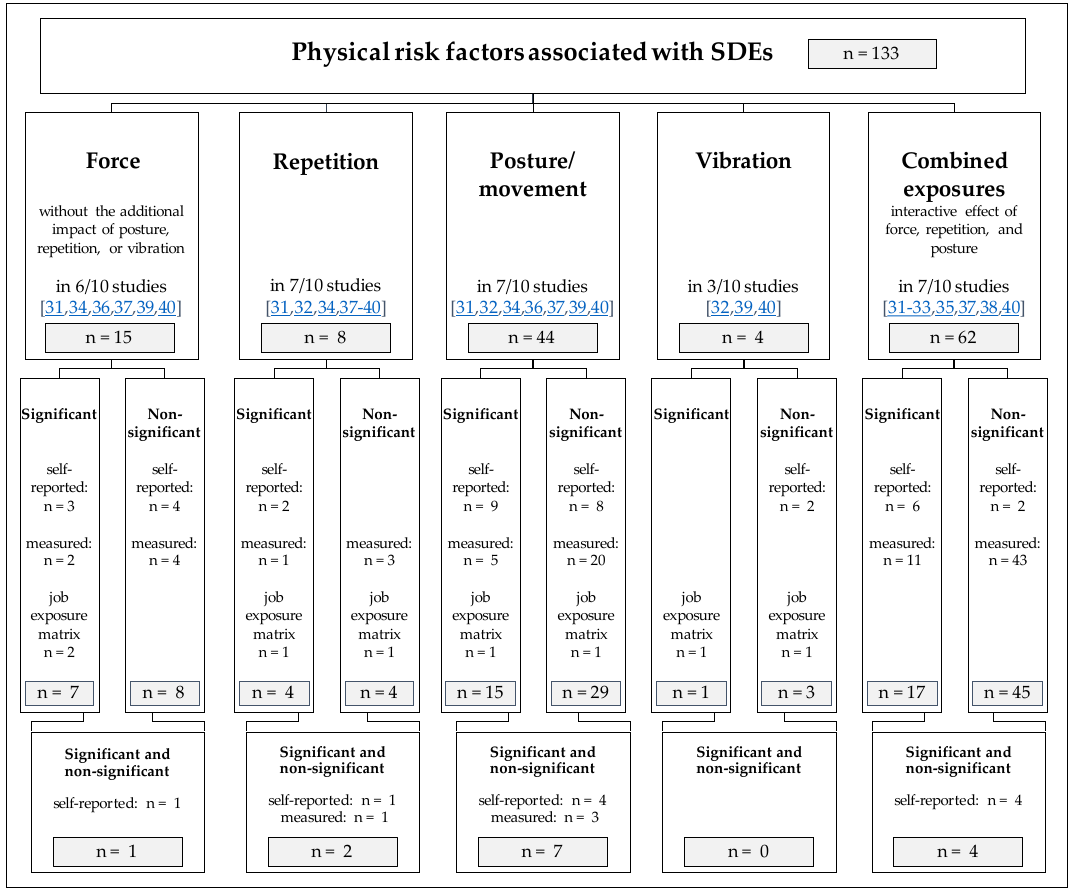
exposure categories: see Table 4, Supplementary File VII (Table S5), Supplementary File VIII (Table S6)).